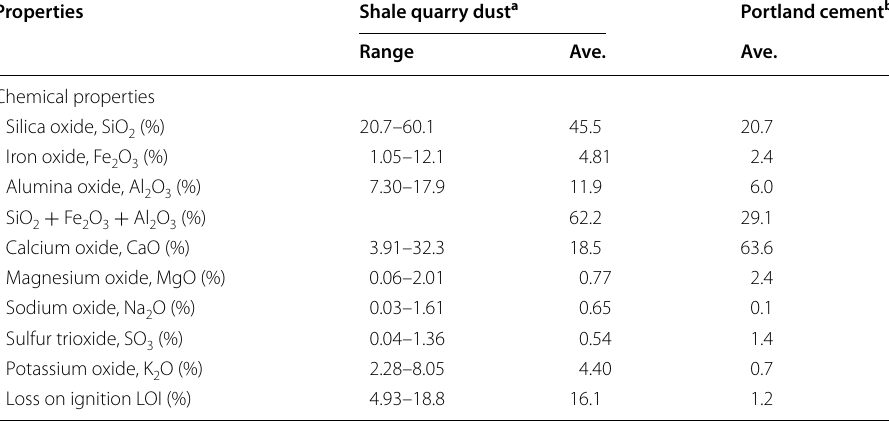
Table 1 Geochemical properties of the untreated shale quarry dust and Portland cement